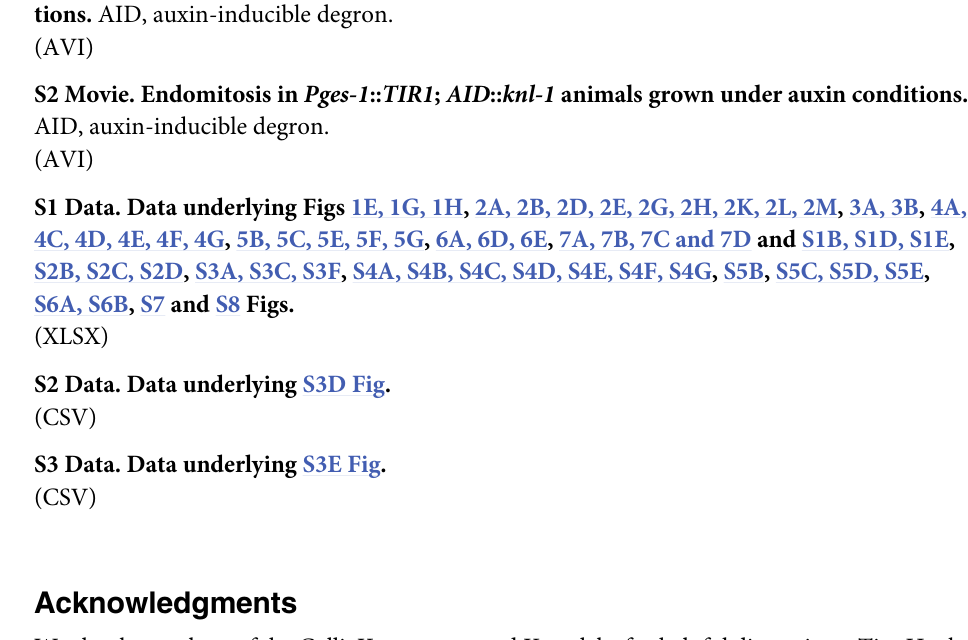
S1 Table. C . elegans strains used in this study. S2 Table. Single guide RNA and ssODN repair template sequences. S3 Table. smFISH probe sequences. smFISH, single molecule fluorescence in situ hybridiza- tion.